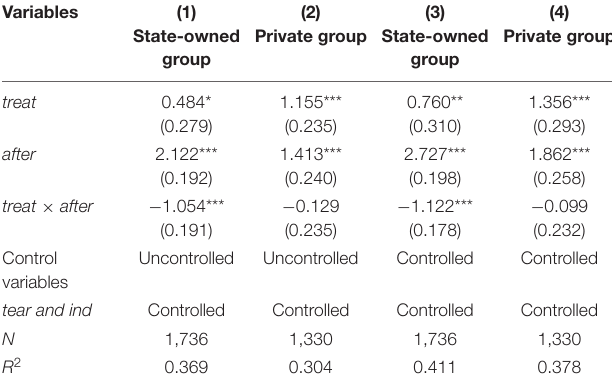
TABLE 7 | Sub-property rights DID regression results.